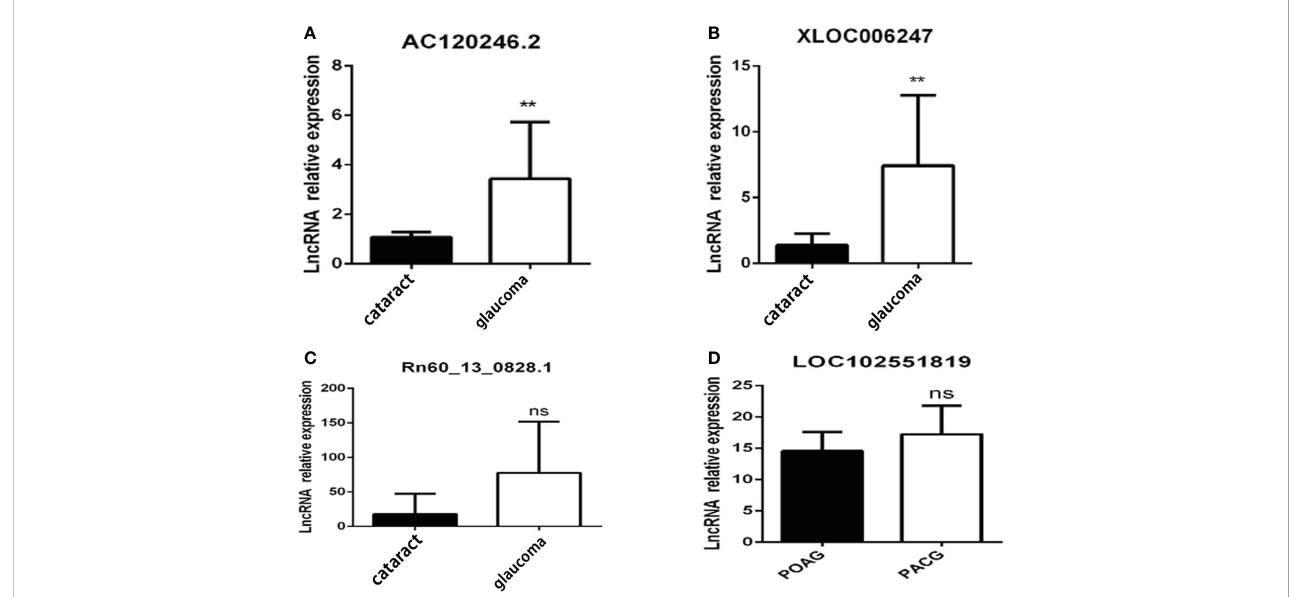
FIGURE 6 Candidate lncRNA expression in clinical patients. Candidate lncRNA expression in the aqueous humor (A – C) or iris (D) from patients with glaucoma (n=10) and patients with cataracts(n=5). **p < 0.01, ns p